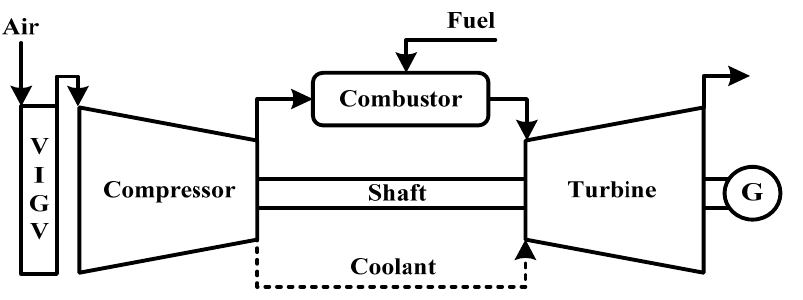
Figure 4. Configuration of the gas turbine.